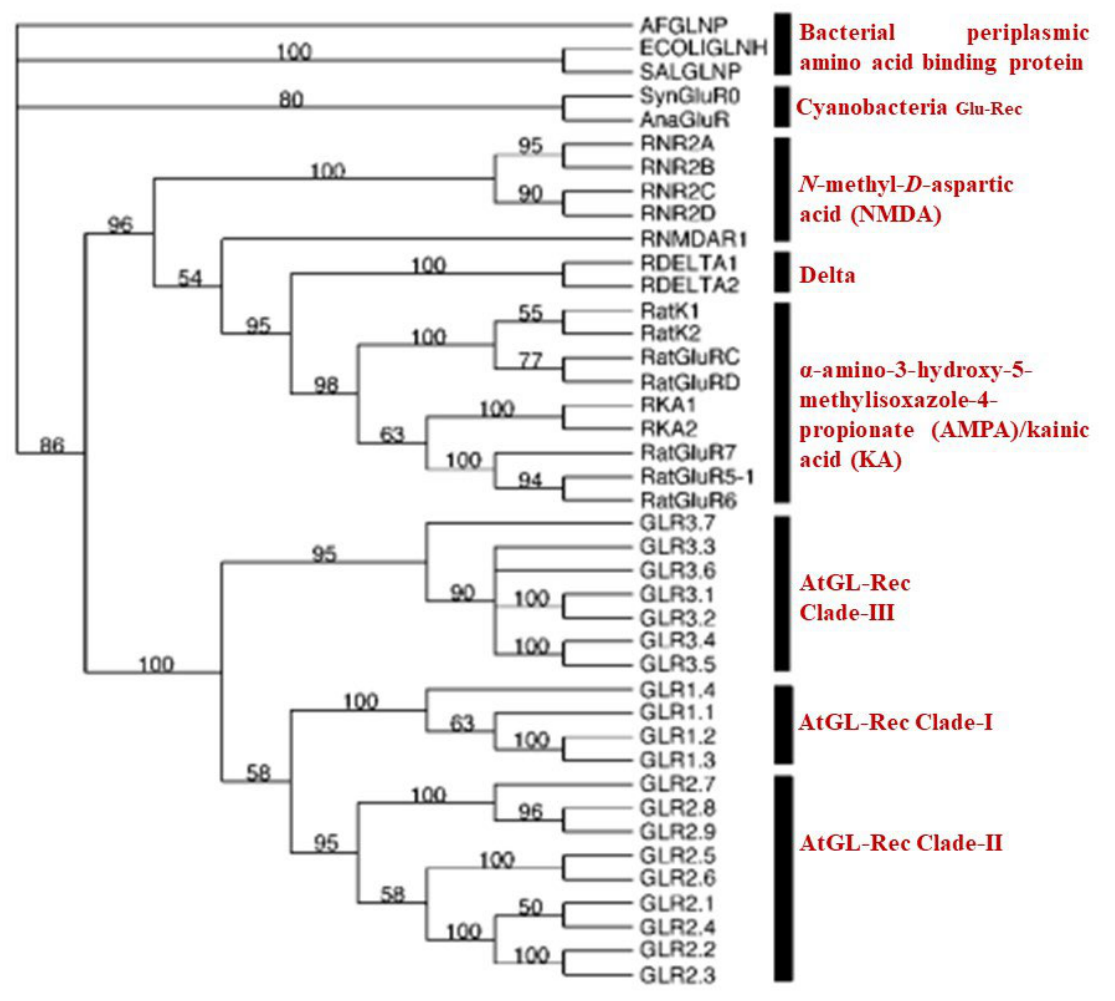
Figure 2. Evolutionary tree of AtGluR- proposed by Chiu et al., 2002 [12].